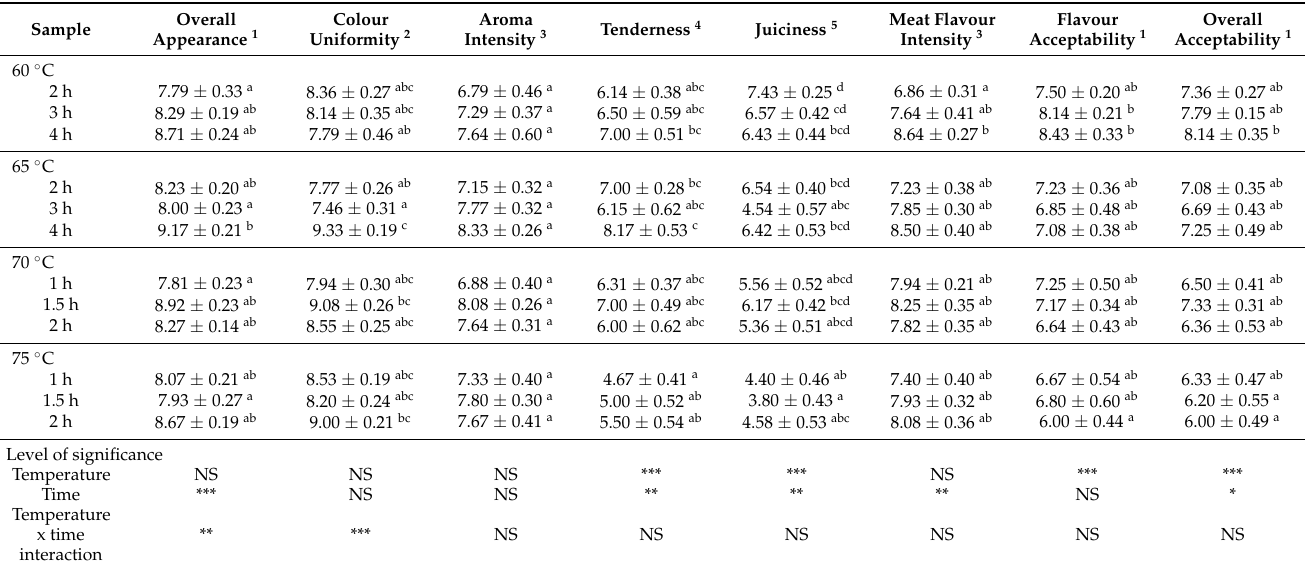
Table 5. Sensory attributes of sous vide cooked pork loin (mean ±